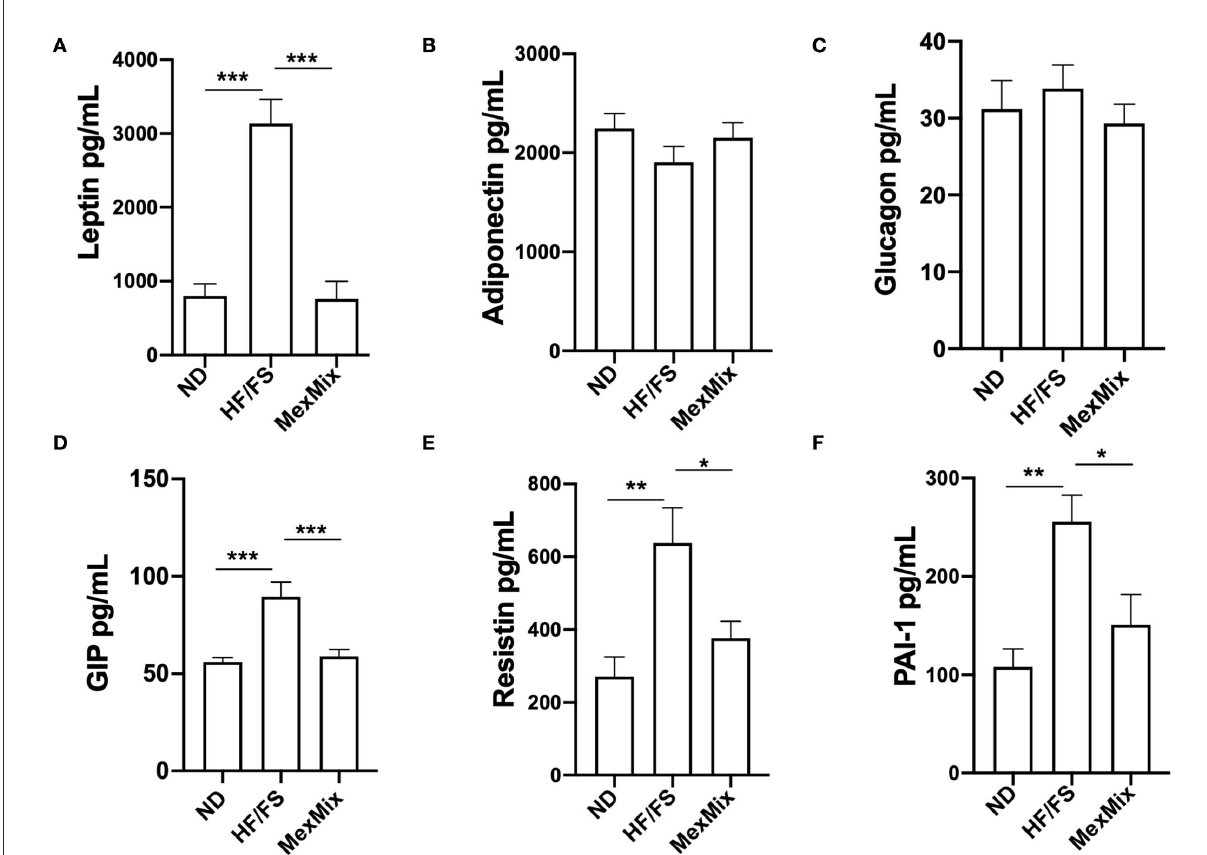
FIGURE3 Effect of MexMix diet in serum adipokines. (A) Leptin levels. (B) Adiponectin levels. (C) Glucagon levels. (D) GIP values. (E) Resistin levels. (F) PAI-1 values. Data represent mean ± SEM (* p < 0.05; ** p < 0.01; *** p <